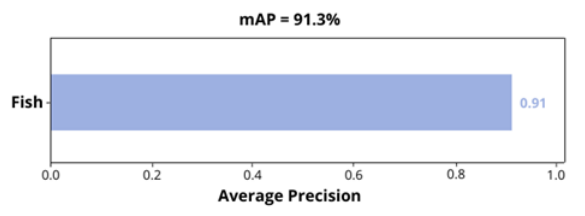
Figure 14 . Mean Average